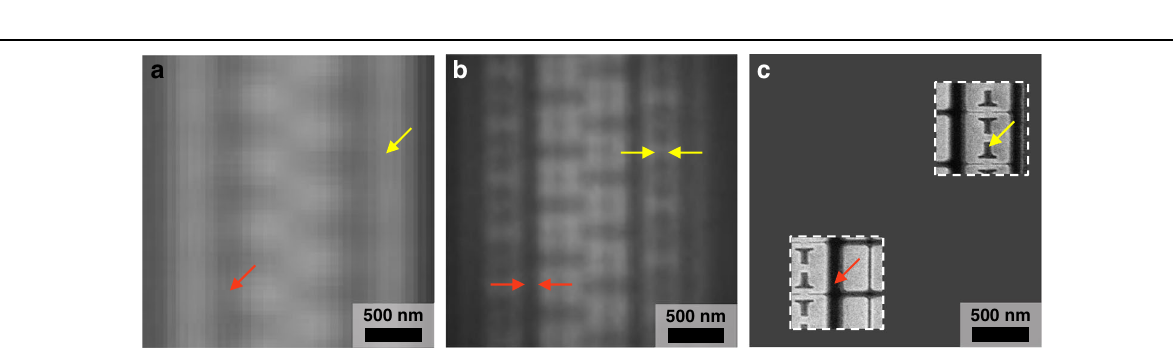
Fig. 9 Images of the SWD area in the DRAM. Images of the SWD area in the DRAM imaged by a ×100 with 0.9 N.A. and b MASR. c Corresponding SEM image. 57 nm CD indicated by yellow arrows and 146 nm CD indicated by red